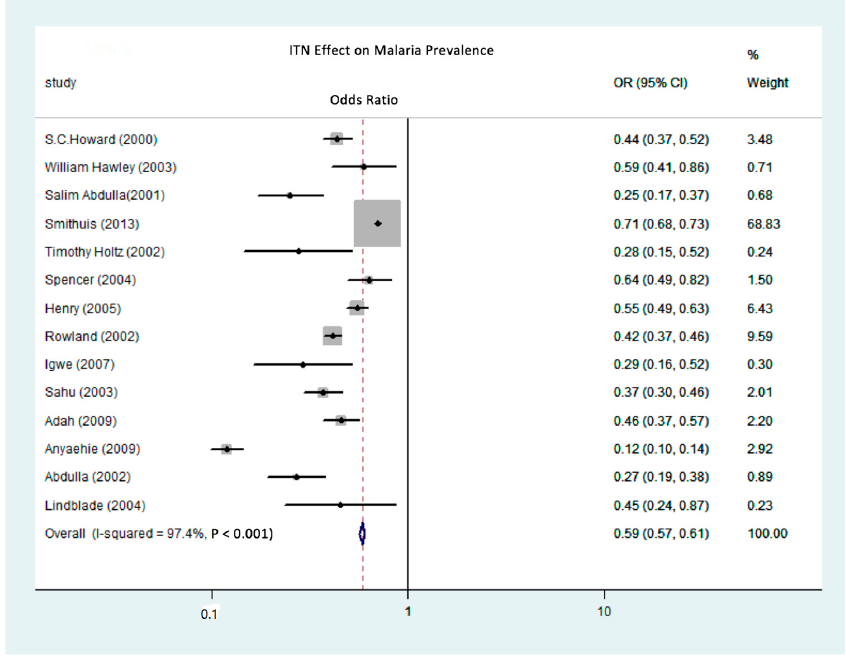
Figure 3. Forest plot of the meta-regression analysis of the odds ratios of the reduction of malaria prevalence due to the use of ITNs.